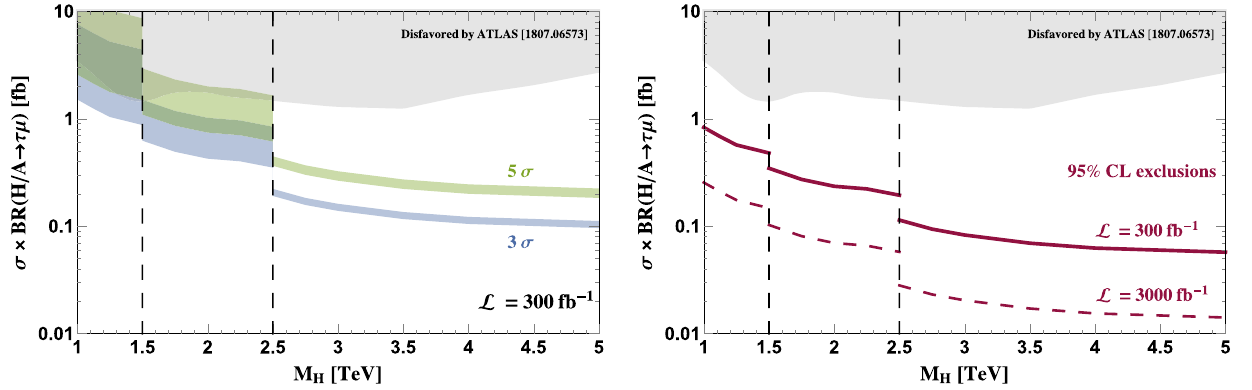
Fig. 4 Left:3 σ (blue)and5 σ (green)significanceswith L = 300fb − 1 . The shadowed contours over the lines show the effect of adding up to a 30% of systematic errors. Right: 95% exclusion limits with L = 300 fb − 1 (solid red line) and scaled, as explained in the text, to L = 3000